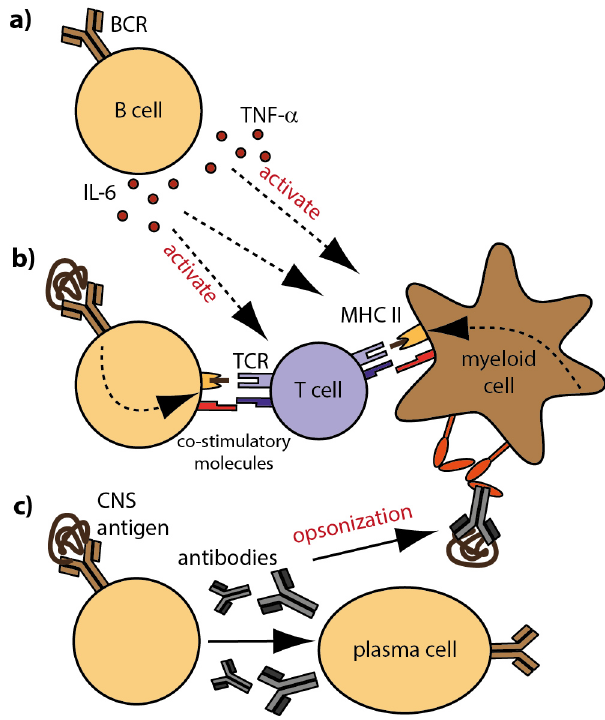
Figure 1. Cellular and molecular B cell properties in MS; ( a ) B cells modulate the activation and differentiation of immune cells by secretion of pro- and anti-inflammatory cytokines; ( b ) Antigen-specific B cells recognize CNS antigen via their BCR and internalize, process and present linearized antigens to responding T cells. Ligation of co-stimulatory molecules and secretion of pro-inflammatory cytokines foster the generation of effector T cells; ( c ) B cells differentiate into antibody-producing plasma cells. Secreted CNS-reactive antibodies that reach the CNS contribute to demyelination and inflammation by complement-mediated cytotoxicity. In the periphery, opsonization of rare CNS antigen by antibodies fosters the generation of auto-reactive T cells; Fc receptors on myeloid APC recognize antibody-antigen complexes and trigger internalization, processing and presentation of opsonized antigen to responding T cells. Definitions: APC = antigen-presenting cells; BCR = B cell receptor; CNS = central nervous system.